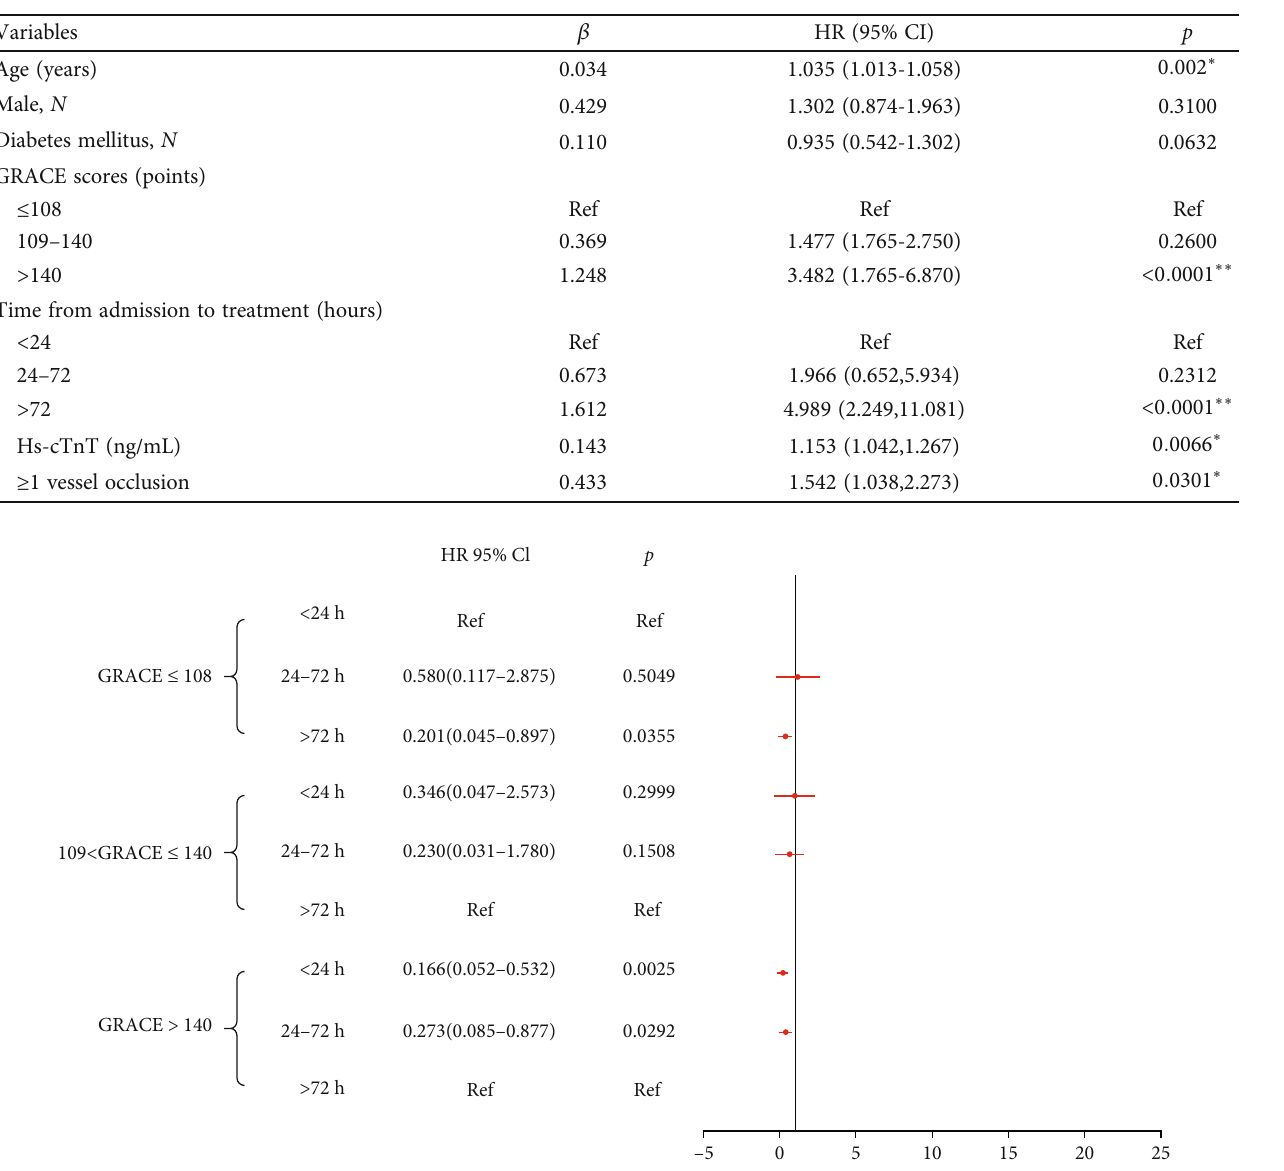
Table 3: MACE event Cox multifactor regression